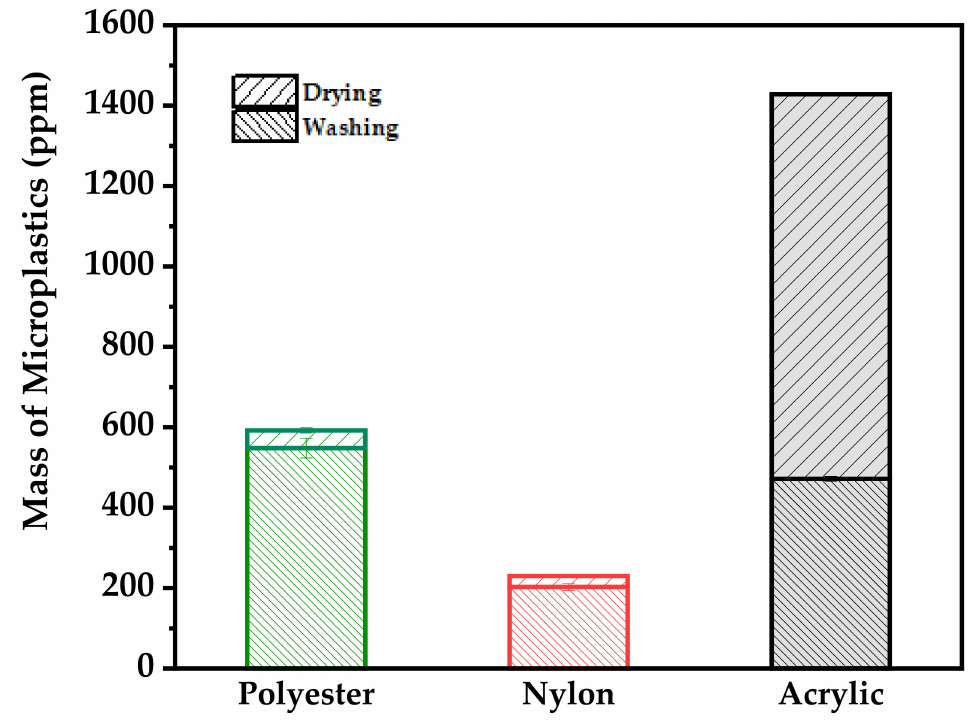
Figure 5. The total mass of microplastics generated by washing and drying.